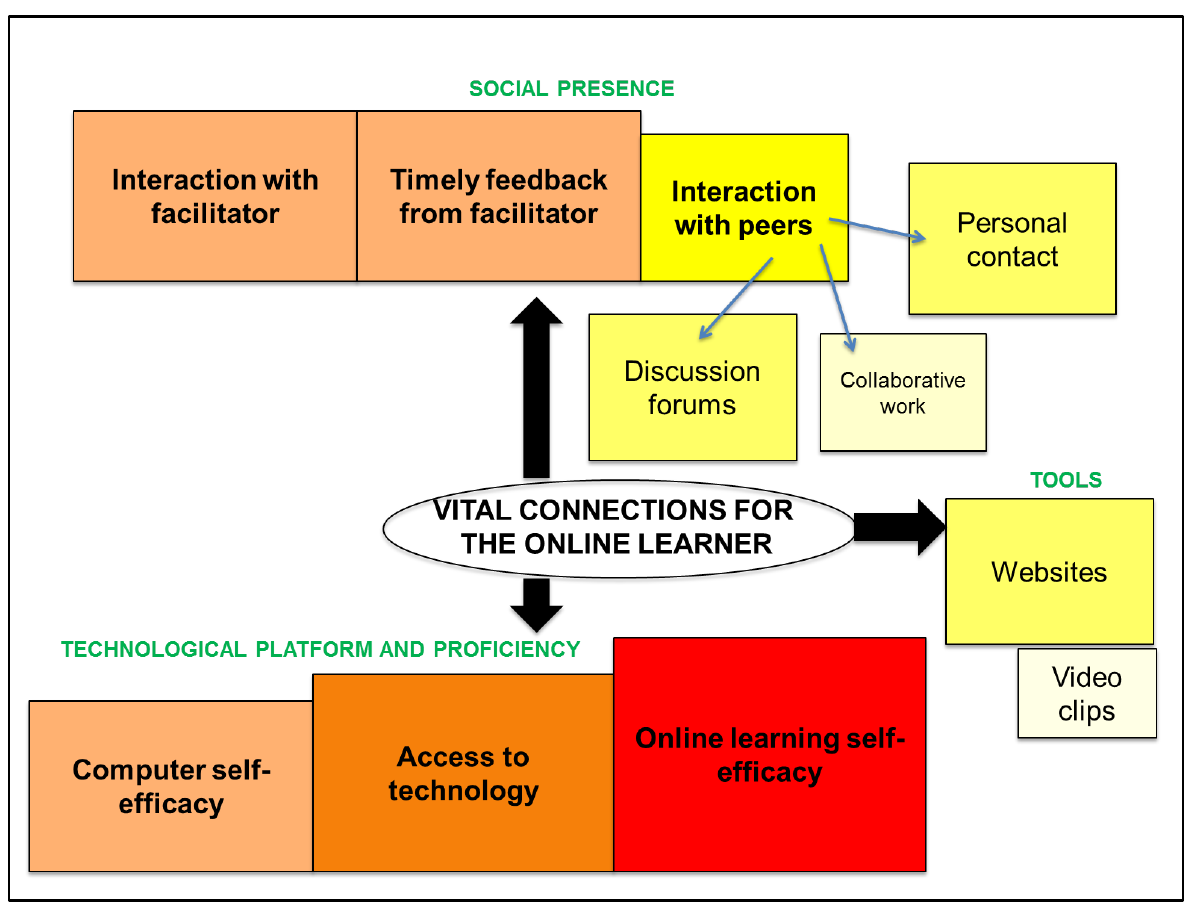
Figure 6. Model of vital connections for the online